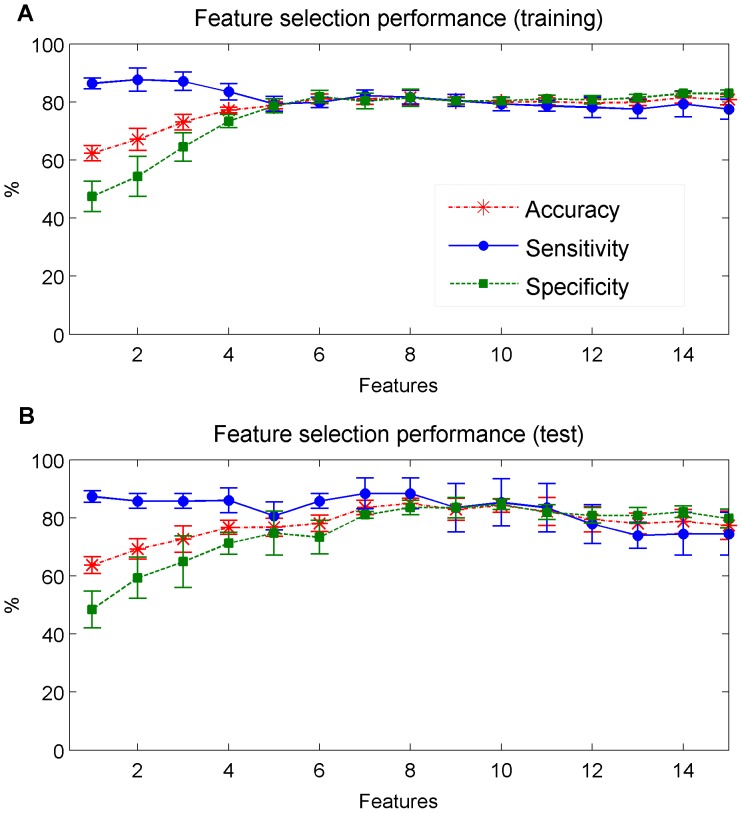
Performance of the feature selection.The performance is represented in terms of accuracy, sensitivity and specificity in classifying SDB and NonSDB children, whenever the feature that provided the higher AUC (with the training set) was included in the linear discriminant. The results obtained with (A) the training dataset (with internal LOO cross-validation) and (B) the test dataset (with external 4-fold cross-validation) are illustrated.